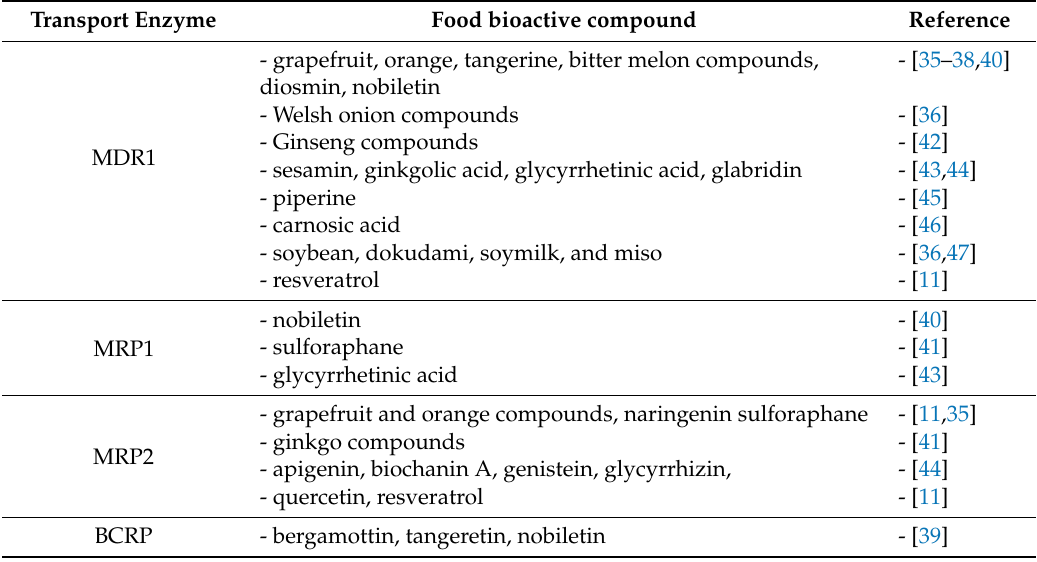
Table 2. Enteric and hepatic transporters of the ATP-binding cassette (ABC) superfamily that are targeted by food bioactive